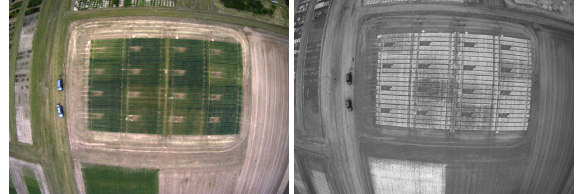
Figure 1: Raw RGB (left) and NIR (right) sample images of a fertiliza- tion test field (altitude approx. 50 m).